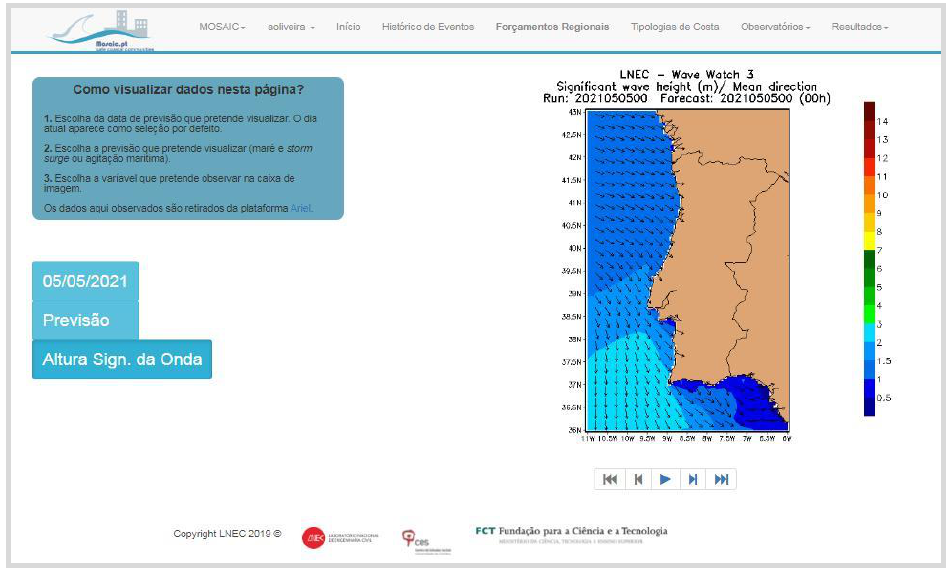
Figure 9. Sample significant wave height predictions. The user can use the slider to move back and forth in time.